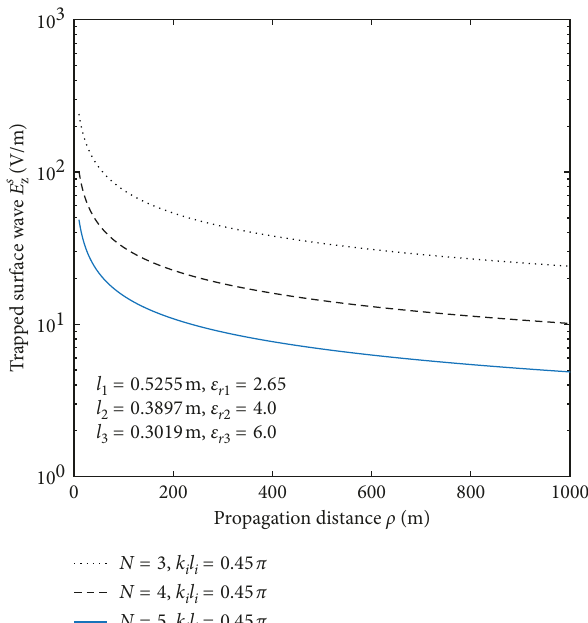
( ρ ,z )| generated by a vertical dipole in the presence of three-layered to five- 0 z